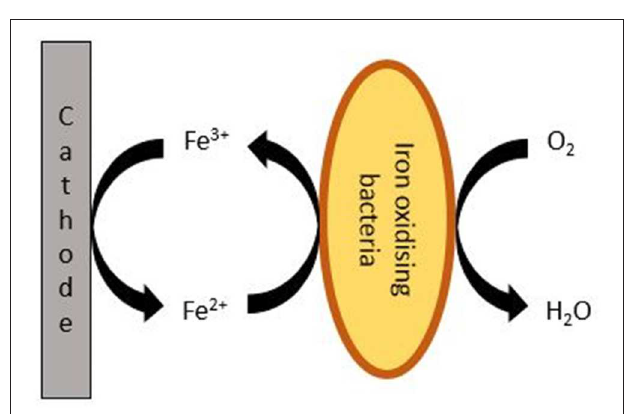
FIGURE 5 | Schematic of the suggested reaction occurring in the cathodic compartment.